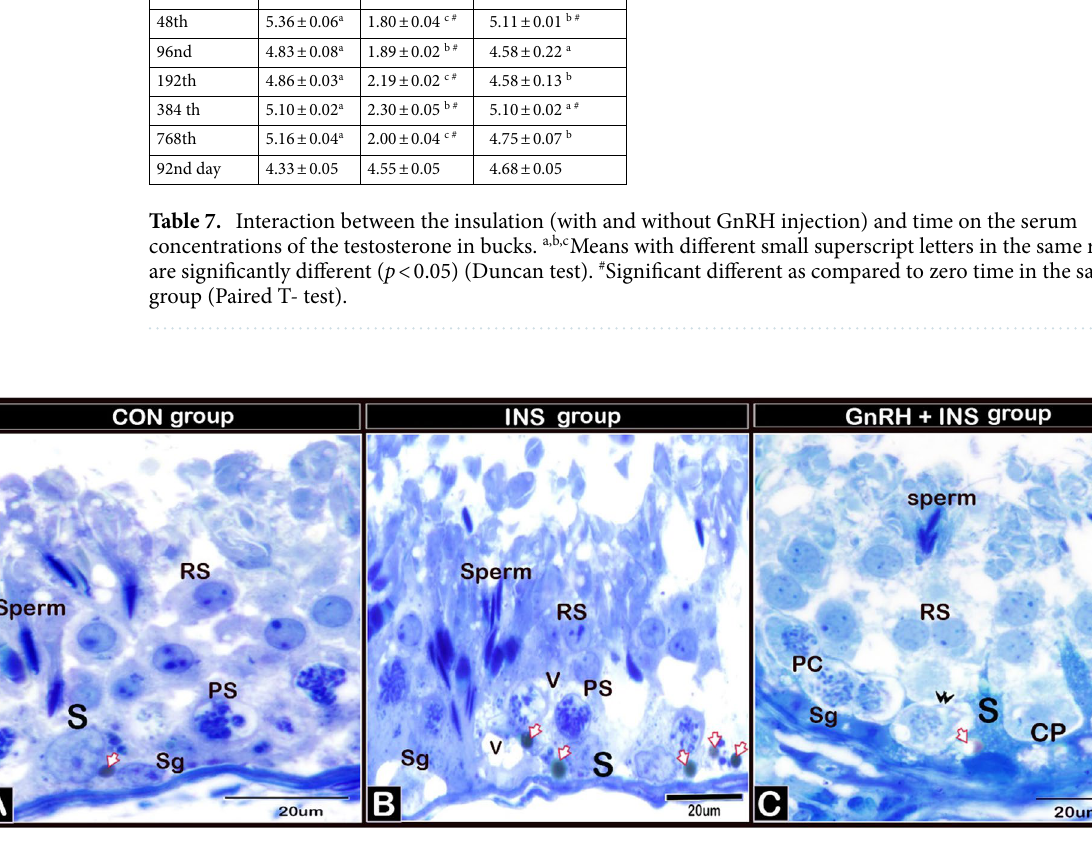
Figure 1. Photomicrographs of semi-thin sections of tubules from adult buck testes stained with toluidine blue (X1000 magnification). Testes in all groups exhibited a typical histological picture of functionally active mature seminiferous tubules. Sertoli cells showed differences in lipid inclusions and cell junctions in different experimental groups: A: Sertoli cells (S) in testis of CON showed low amount of lipid inclusion (arrow) and no vacuoles within the cytoplasm. B: INS showed marked accumulation of lipid droplets in Sertoli cells (arrow) and vacuolization (V) in both Sertoli and primary spermatocytes. C: GnRH + INS showed the Sertoli cells with scanty lipid inclusions, large cytoplasmic processes (CP) and no vacuoles in the Sertoli cells and primary spermatocytes. S: Sertoli cell, and Sg: spermatogonia, PS: primary spermatocytes, RS: round spermatid and